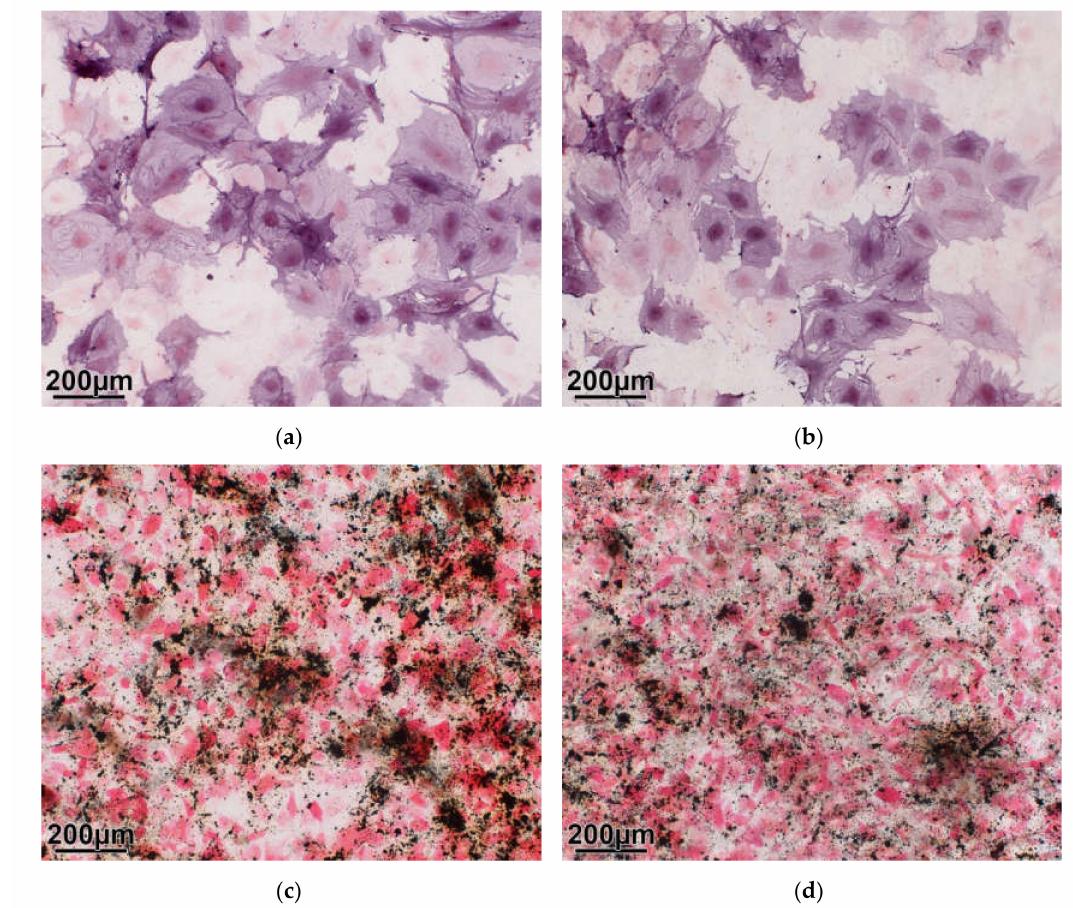
Figure 5. Osteogenic differentiation: ( a , b ) The entire cell surfaces show the enzyme reaction with alkaline phosphatase (violet color). ( c , d ): The black spots indicate clusters of mineral, which is formed at later stages of osteogenic differentiation (here: 28 days). Coated material ( a , c ); uncoated material ( b , d